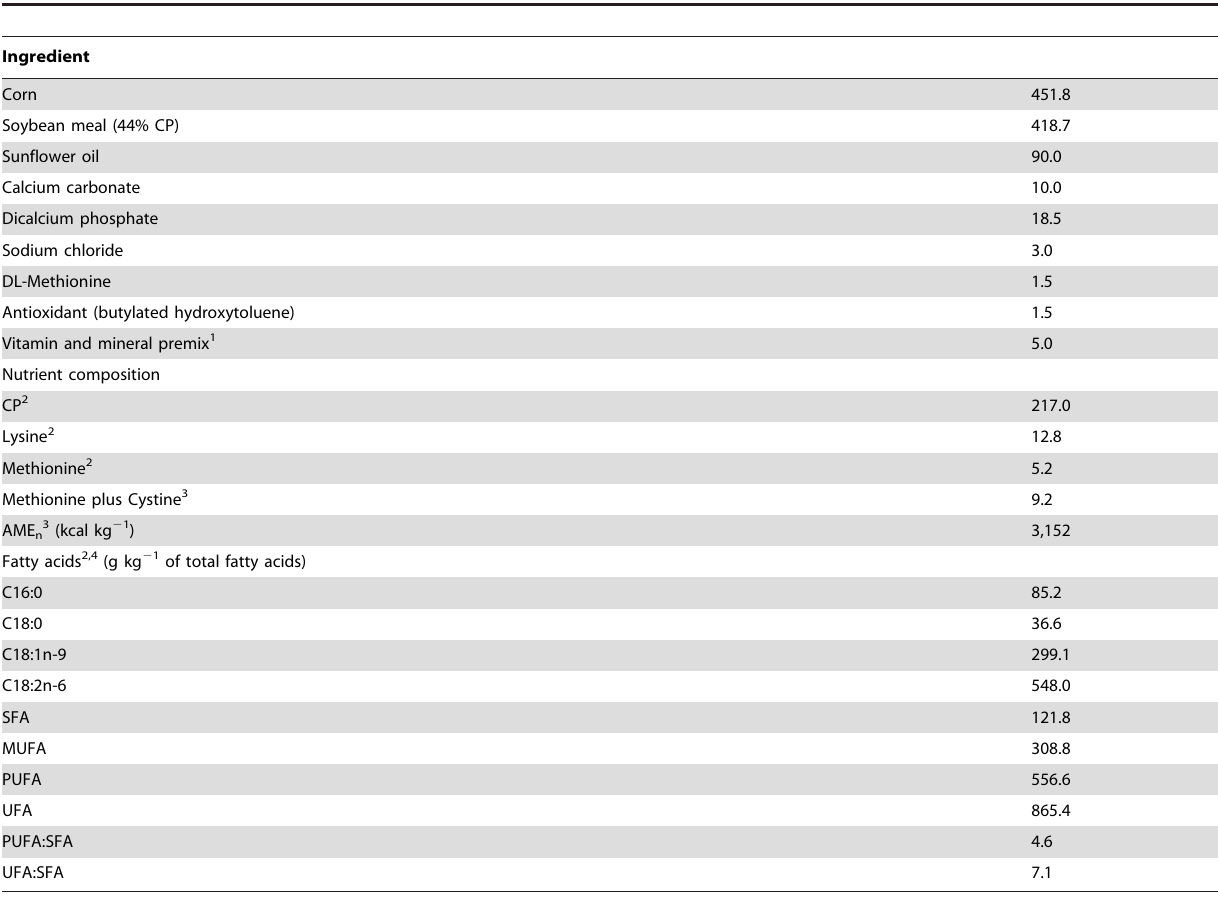
Table 1. Ingredients and nutrient composition of experimental control diet (g kg 2 1 as fed